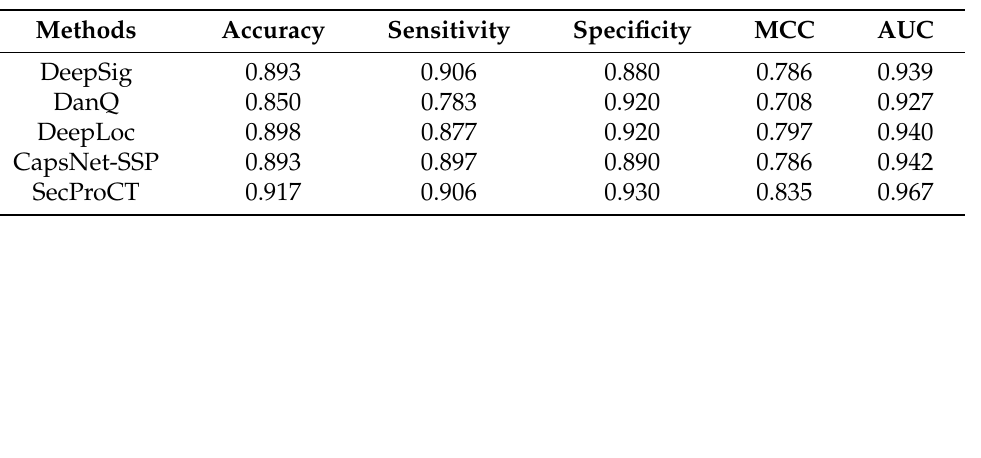
Table 4. Performance comparison with deep learning architectures for predicting blood-secretory